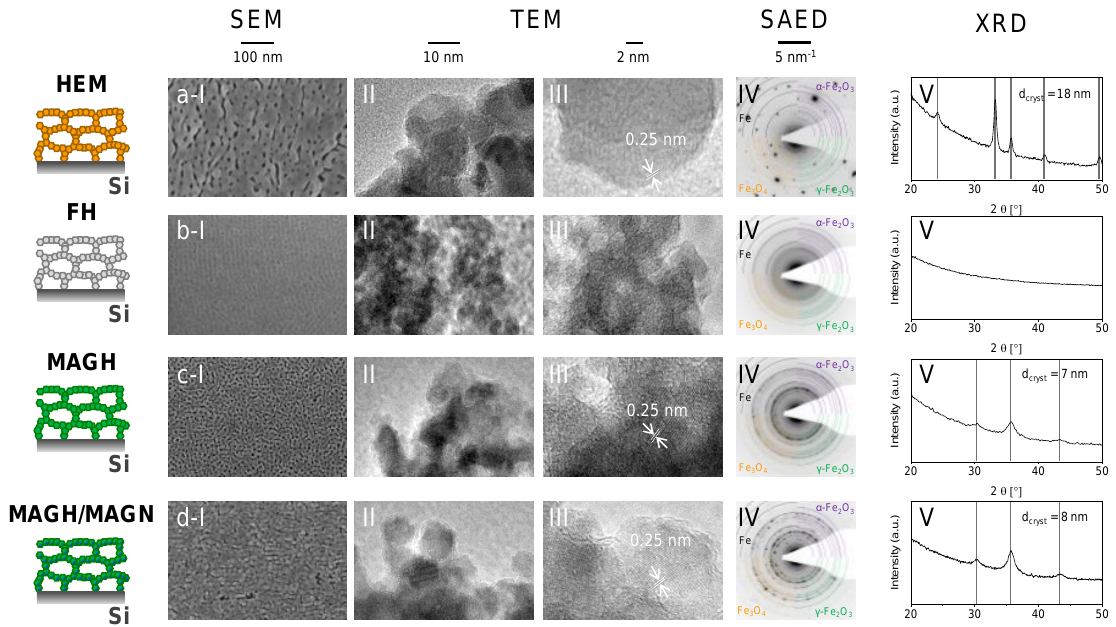
Figure 1. Fresh iron oxide films obtained after controlled exposure of the mesophase to different gas atmospheres. 550 ◦ C air for 10 min forms ( a ) HEM and 400 ◦ C air for 10 min ( b ) FH. 350 ◦ C in N 2 for 5 h forms ( c ) MAGH. 400 ◦ C in N 2 for 2 h → 350 ◦ C in H 2 /Ar for 1 h ( d ) MAGH/MAGN. All samples were characterized by (I) SEM, (II/III) TEM, (IV) SAED and (V) GI−XRD.